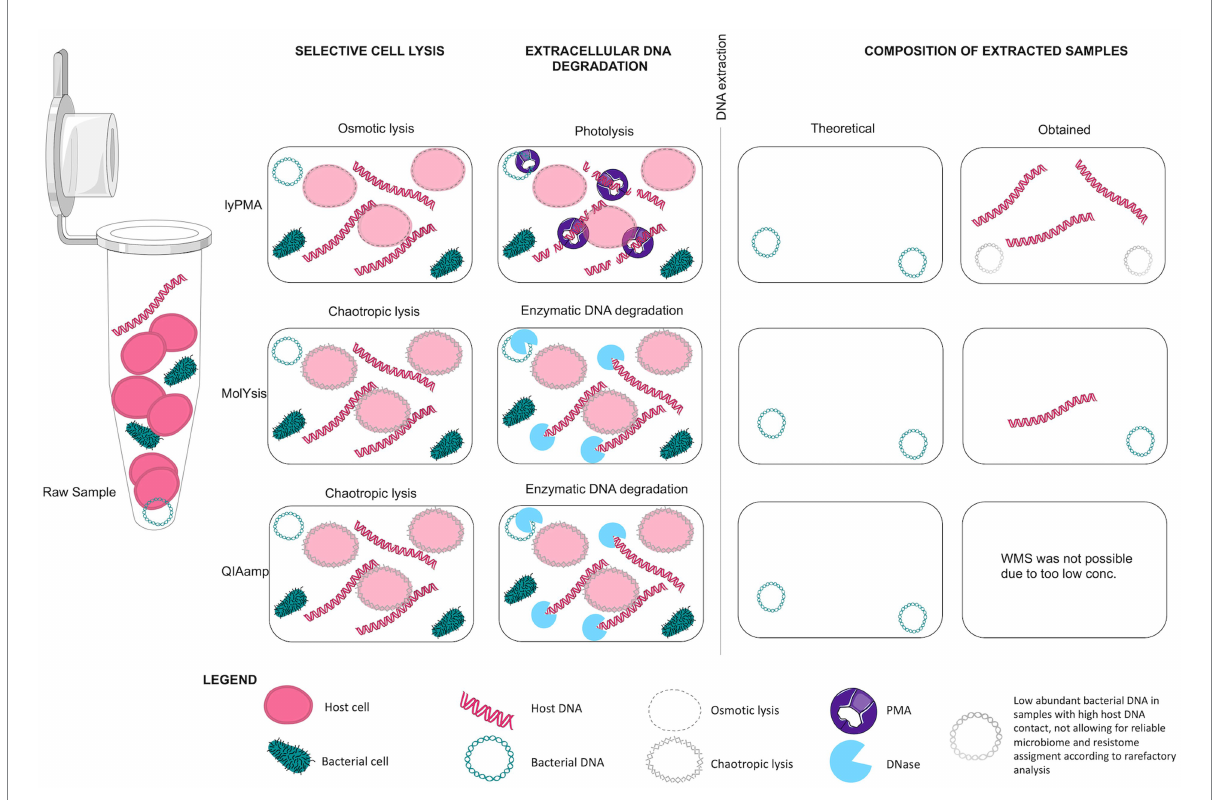
FIGURE 9 Mechanism of Host DNA depletion protocols. Graphical illustration of different host DNA depletion protocols according to their mechanism of action. LyPMA protocol is composed of osmotic lysis and DNA fragmentation with photolysis. MolYsis and QIAamp use chemical lysis of host cells followed by enzymatic degradation of extracellular DNA. In theory, all methods result in selective lysis of human cells, followed by removal of extracellular DNA, human and bacterial. In our study, only samples depleted with MolYsis ™ showed a reduction in host DNA content. Parts of the figure were drawn by using pictures from Servier Medical Art by Servier (smart.